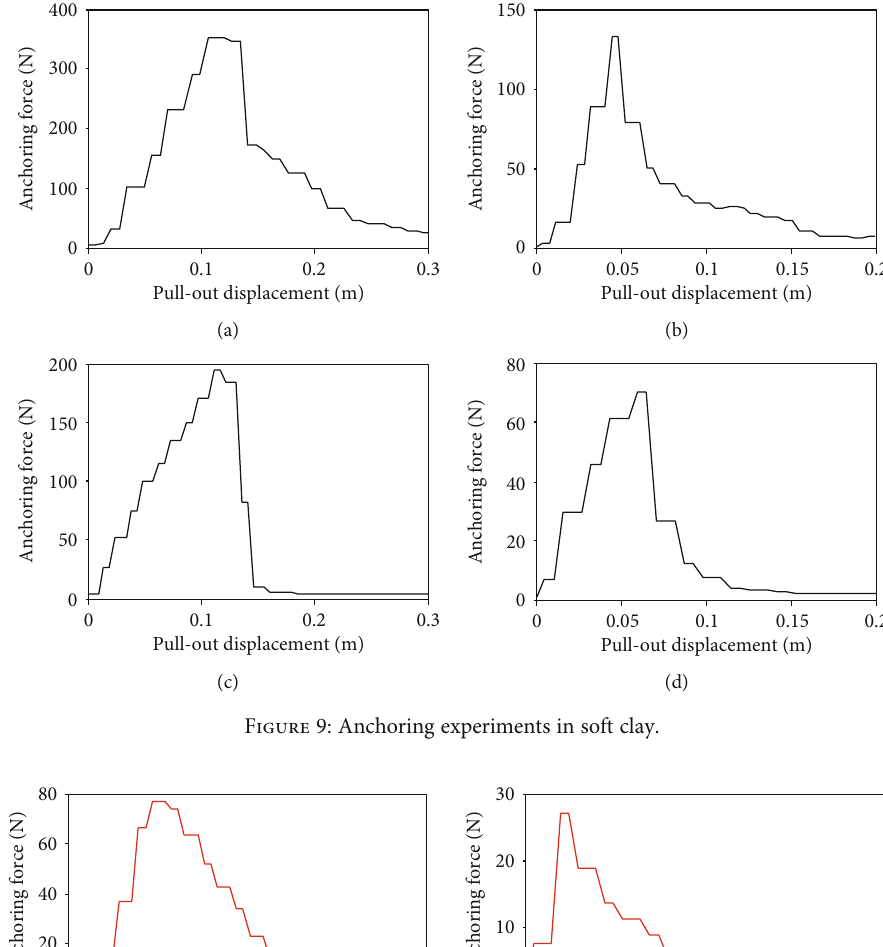
Figure 9: Anchoring experiments in soft clay.